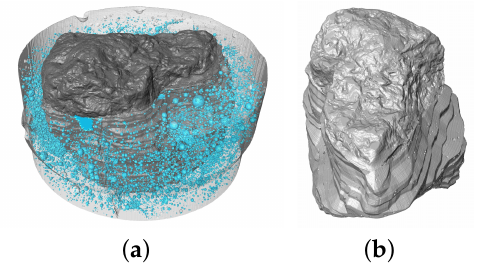
Figure 12. Crushed granite’s microCT scan images: ( a ) embedded in cement paste cylinder, and ( b ) views of the aggregate’s exposed surface.